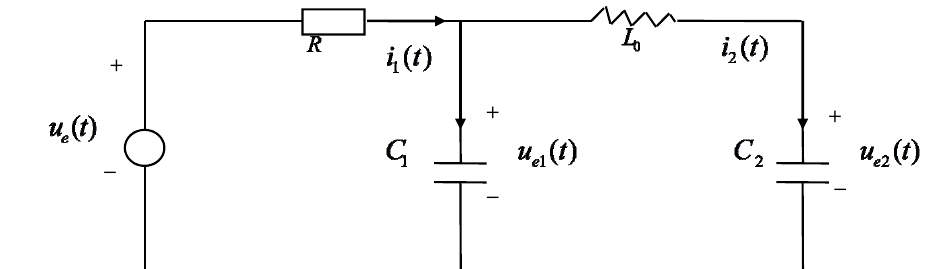
Figure 5. The circuit system.